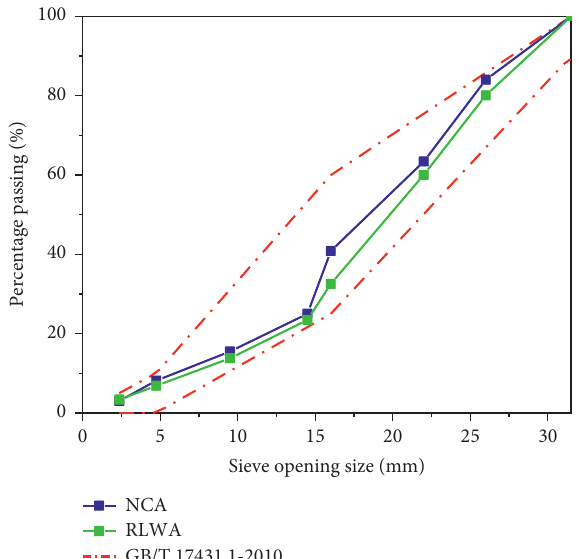
Figure 1: Sieve analysis of coarse